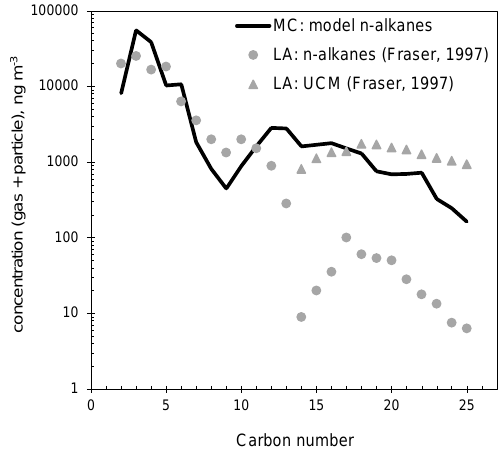
Fig. 4. Comparison between modeled and observed OH reactivity of the emitted NMHCs within Mexico City, averaged over daytime hours (09:00 to 18:00) and expressed relative to butane.